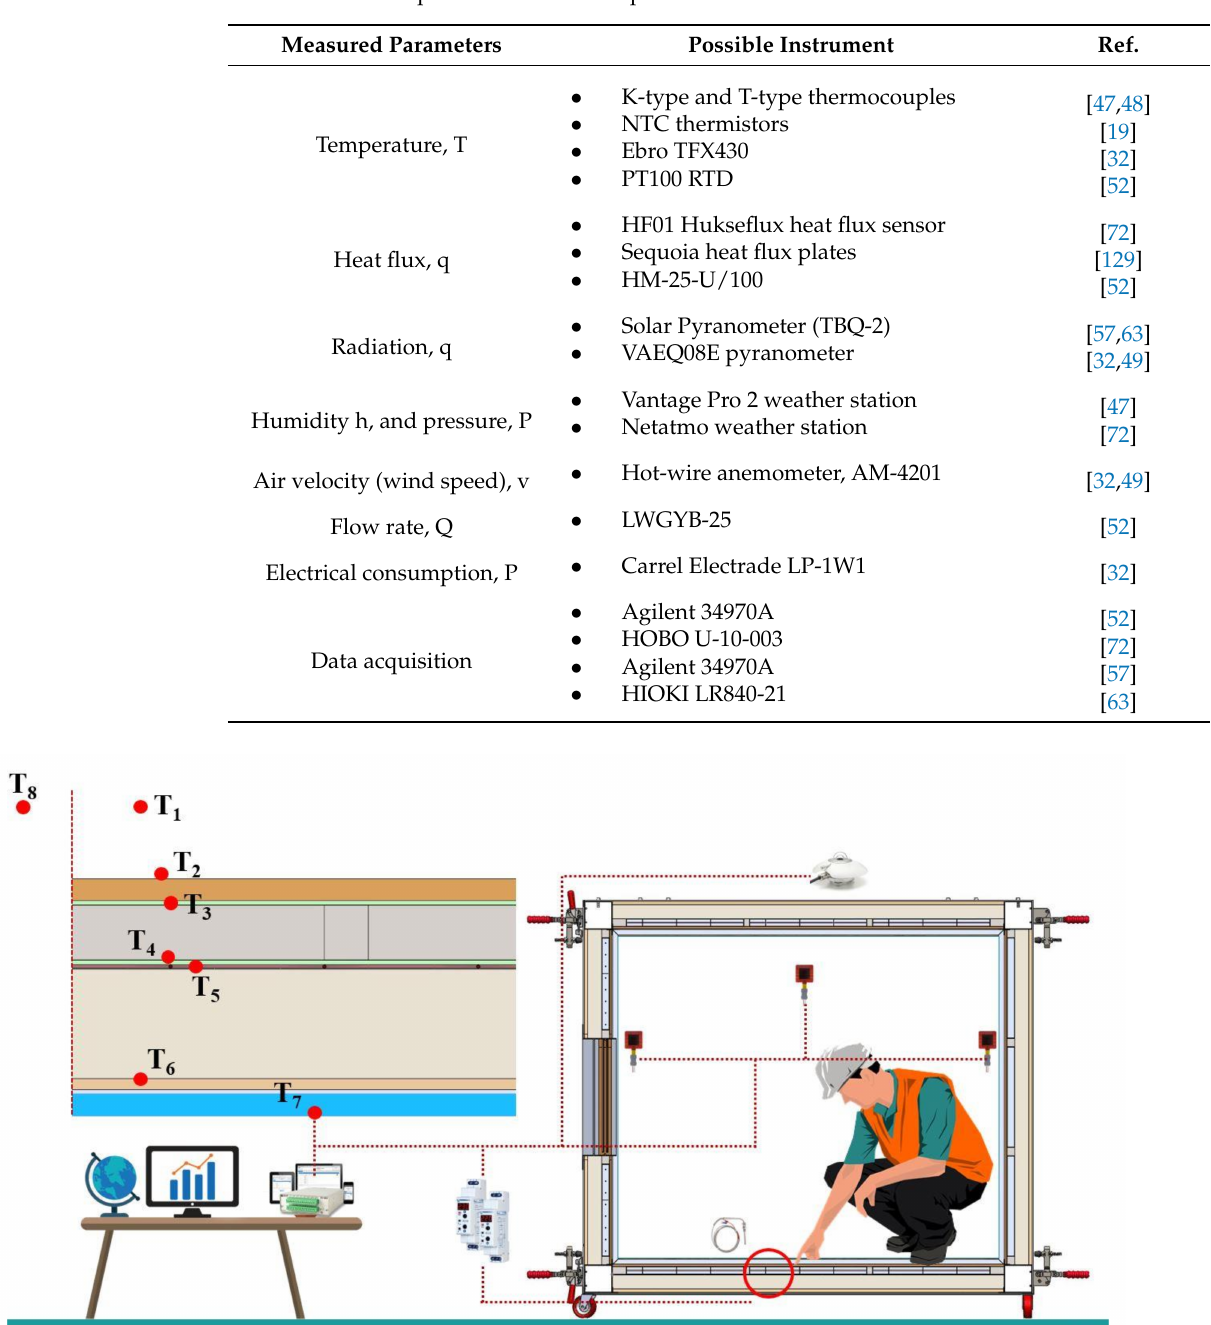
Table 5. Measured parameters and their possible instrumentations from literature.